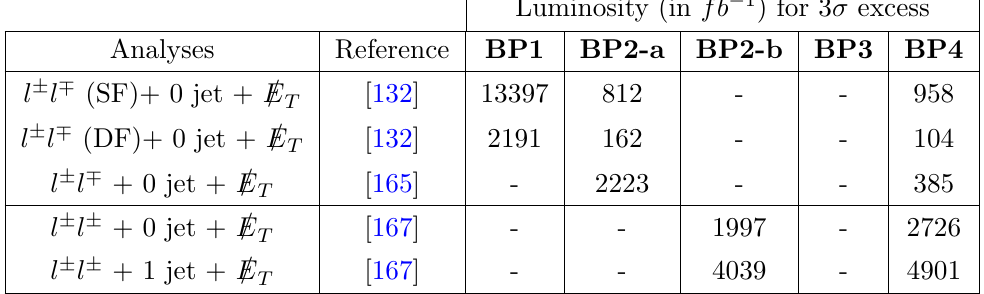
Table 5 . Forecast for luminosity for 3 (cid:27) excess using present experimental searches using 36 fb (cid:0) 1 of data at LHC. The blank spaces indicate that the benchmark is not sensitive to the (cid:12)nal state analysis. We do not show the forecast from current monoleptonic searches as it gives much weaker sensitivity to our